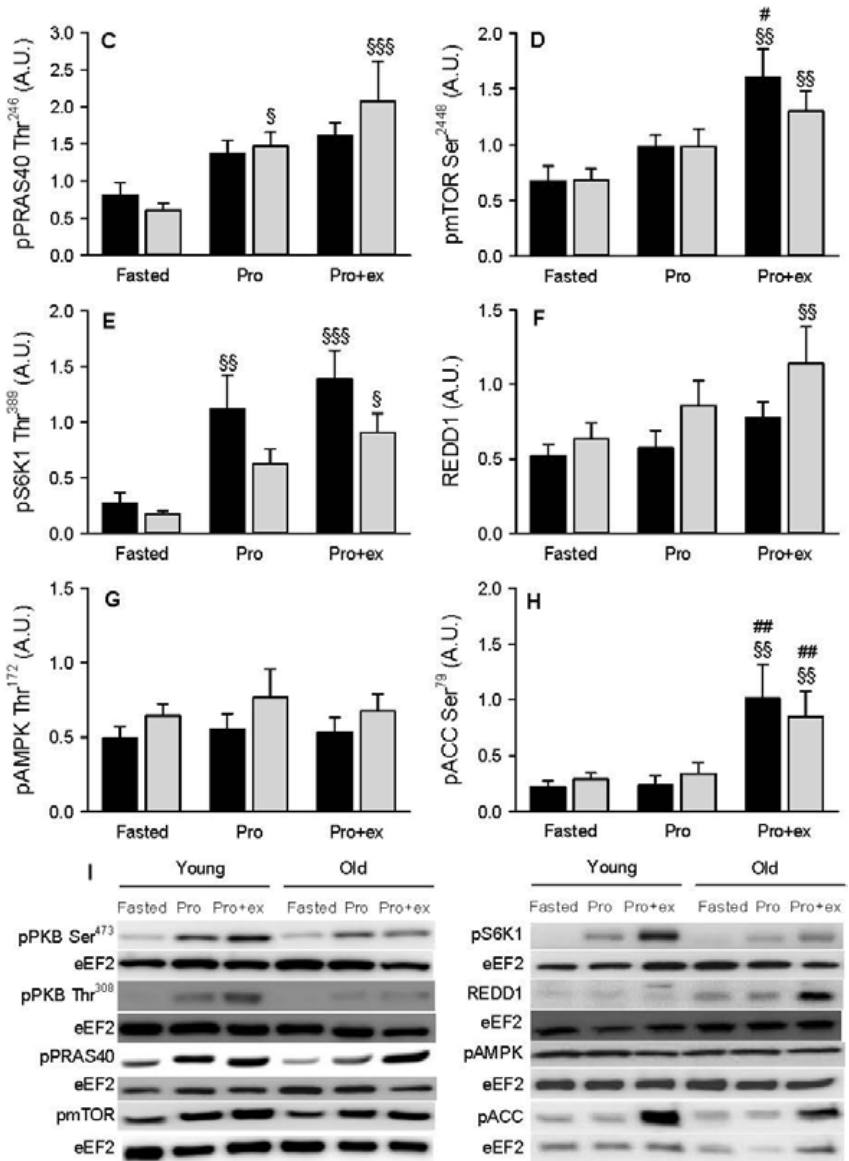
Figure 2. Effect of aging on the PKB/mTOR pathway activation after resistance exercise and protein intake. ( A ) Phospho-PKB Ser 473 ; ( B ) phospho-PKB Thr 308 ( C ) phospho-PRAS40 Thr 246 ; ( D ) phospho-mTOR Ser 2448 ; ( E ) phospho-S6K1 Thr 389 ; ( F ) REDD1 expression; ( G ) phospho-AMPK Thr 172 and ( H ) phospho-ACC Ser 79 in Fasted, Pro, and Pro+ex conditions in young and older subjects; ( I ) Representative western blots. Values are means ± SEM. § p < 0.05, §§ p < 0.01, §§§ p < 0.001 vs. Fasted same age. # p < 0.05, ## p < 0.01 vs. Pro same age. * p < 0.05 vs. Young same condition.